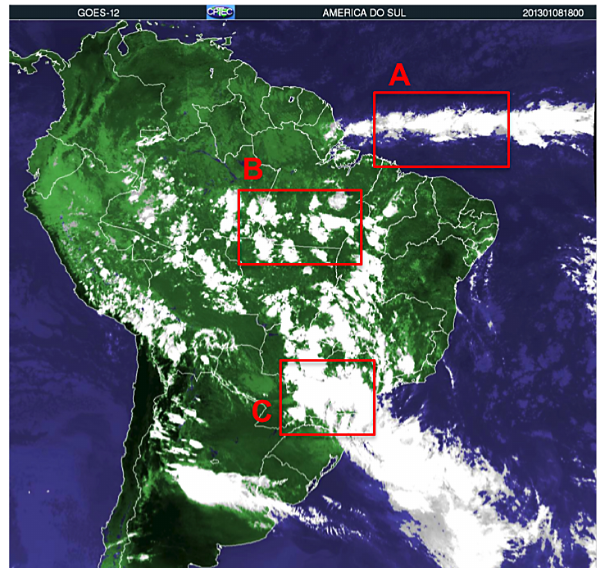
Figure 9. Vertical profiles of convective heating ( A , C , and E ) and drying ( B , D , and F ) for box A (A, B) , box B (C, D) , and box C (E, F) (C,D), and box C (E, F).